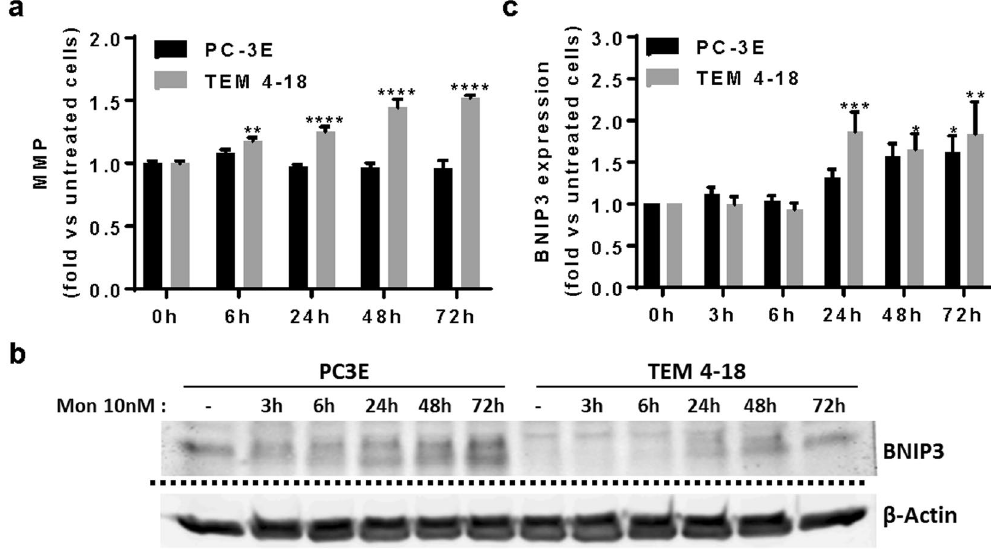
Figure 3. Monensin perturbs mitochondrial function and induces mitochondrial damage in TEM 4-18 cells. Cells were treated for 3 h to 72 h with monensin (10 nM). ( a ) Mitochondrial membrane potential (JC-1 staining) (n ≥ 8) and ( b , c ) expression of BNIP3 (Western blot) were evaluated (n ≥ 6). ( b ) shows a representative Western blot. The blot was cut based on migration of molecular weight markers and stained separately for BNIP3 and β -actin. The images shown are cropped from sections from the blots shown in Supplementary Fig. S6. Data represent mean values ± SEM. * p < 0.05, ** p < 0.01, *** p < 0.005, **** p <